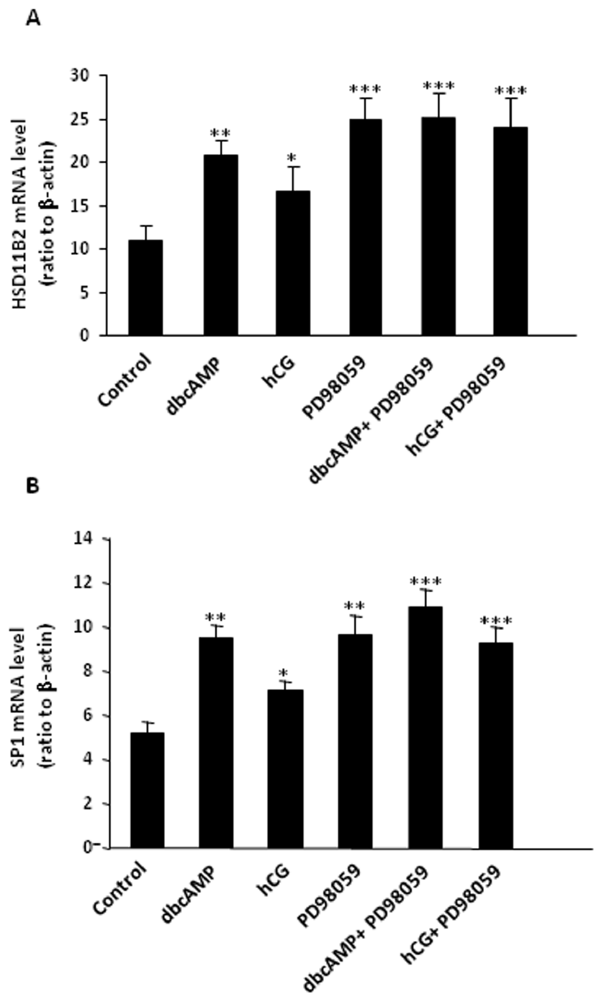
Figure 4. (A) Effect of PD98059(ERK1/2 MAPK inhibitor, 50 m M) on the basal and dbcAMP (100 m M) and hCG (10 IU/ml)- induced HSD11B2 mRNA expression in human placental syncytiotrophoblasts. *p , 0.05, **p , 0.01, ***p , 0.001 versus con- trol (n=4) (B) Effect of PD98059 (ERK1/2 MAPK inhibitor, 50 m M) on the basal and dbcAMP(100 m M) and hCG (10 IU/ml)-induced SP1 mRNA expression in human placental syncytiotrophoblasts. *p , 0.05, **p , 0.01, ***p , 0.001 versus control (n=4).